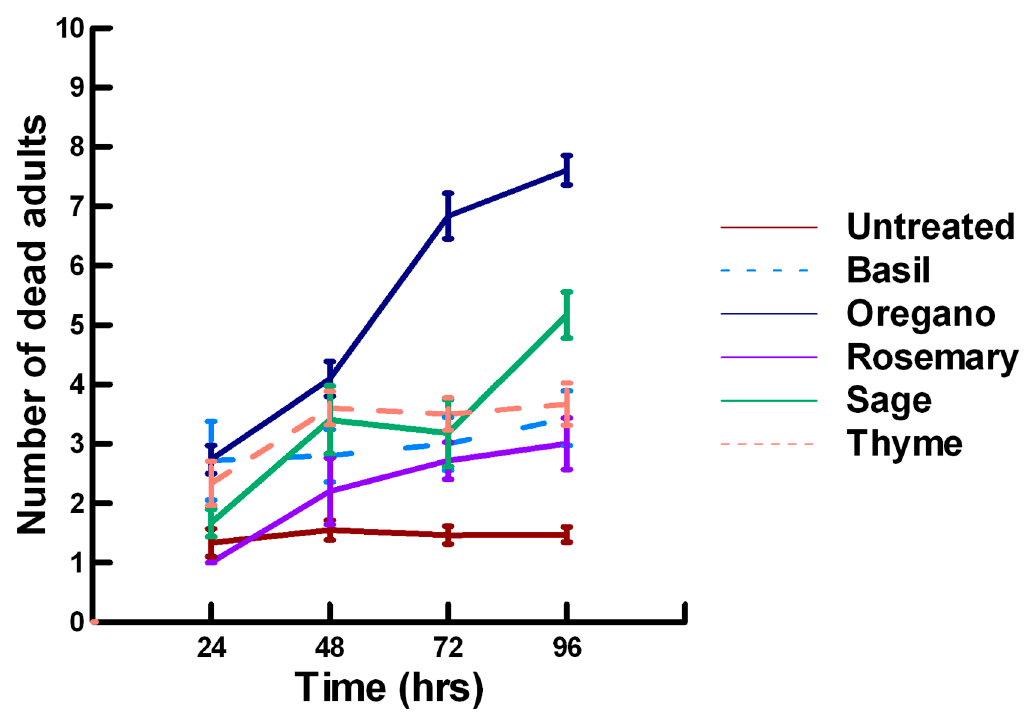
Figure 1. Acute contact toxicity with a low concentration of plant powders from the family Lamiaceae (basil, oregano, rosemary, sage and thyme) adherent to adult Pteromalus venustus . Means and standard error shown.